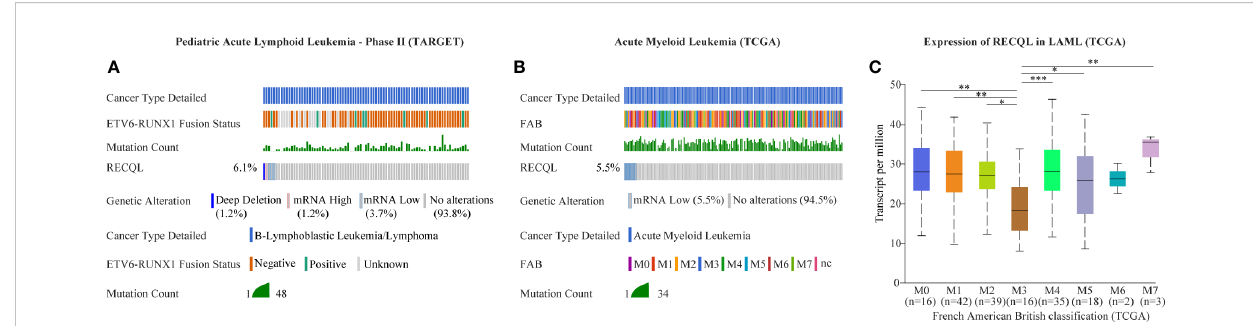
FIGURE 2 Mutation and expression of RECQL potentially involved in acute leukemia. The alteration frequency in RECQL in acute leukemia was analyzed by using the cBioPortal database, including data of AML from TCGA database and data of BCP-ALL from TARGET database. Samples with complete data of gene mutation, CNA and mRNA expression (log RNA Seq V2 RSEM) were retained after screening. (A) The alteration frequency in RECQL in B-ALL patients (Pediatric Acute Lymphoid Leukemia - Phase II, TARGET). (B) The alteration frequency in RECQL in AML patients (TCGA-LAML). (C) Comparison of RECQL gene expression in AML patients with different French American British classi fi cation. AML, Acute Myeloid Leukemia; TCGA, The Cancer Genome Atlas; B- ALL, acute B lymphoblastic leukemia; CNA, copy-number alterations; RSEM, RNA-Seq by Expectation Maximization; TARGET, therapeutically applicable research to generate effective treatments. Statistically signi fi cant differences are indicated as follows: *p < 0.05, **p < 0.01, ***p <